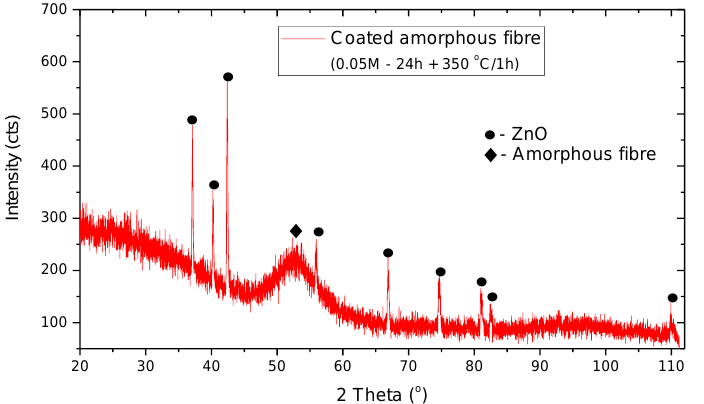
Figure 5. XRD pattern of the fibres coated via hydrothermal method for 24 h using a precursor with a concentration of 0.05M and annealed at 350 °C/1 h.